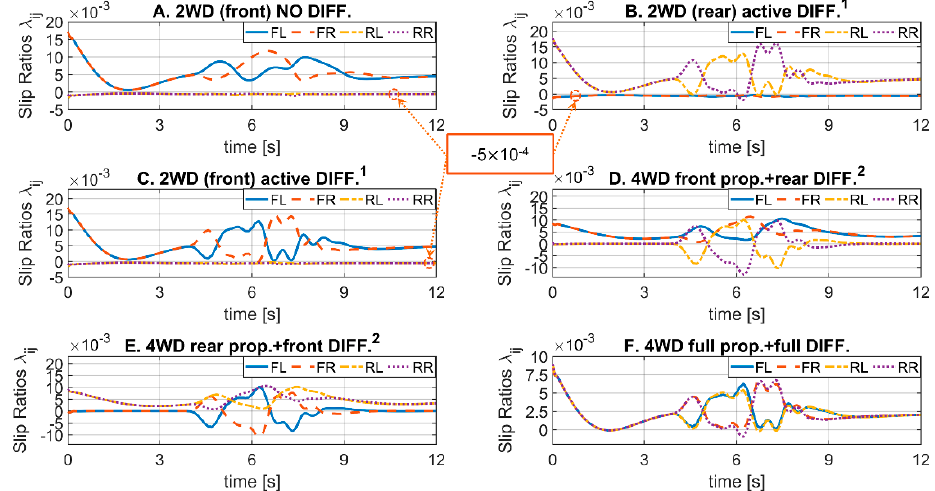
→ Figure 13. DLC Maneuver: four-slips coordination: ( A ) 2WD (front) NO DIFF.{ 𝑑⃗ ((cid:3032)) }; ( B ) 2WD d ( e ) }; ( B ) 2WD (rear) Figure 13. DLC Maneuver: four-slips coordination: ( A ) 2WD (front) NO DIFF.{ (rear) active DIFF.{ 𝑑⃗ ((cid:3029)) }; ( C ) 2WD (front) active DIFF. { 𝑑⃗ ((cid:3034)) }; ( D ) 4WD front prop.+rear DIFF. { 𝑑⃗ ((cid:3033)) }; → → → d ( b ) }; ( C ) 2WD (front) active DIFF. { d ( g ) }; ( D ) 4WD front prop.+rear DIFF. { d ( f ) }; active DIFF.{ → → → → d ( c ) }; ( F ) 4WD full prop.+full DIFF.{ d ( l ) }. [ 1 (B{ d ( b ) },C{ d ( g ) }) and ( E ) 4WD rear prop.+front DIFF. { → → 2 (D{ d ( f ) },E{ d ( c ) }) are dual